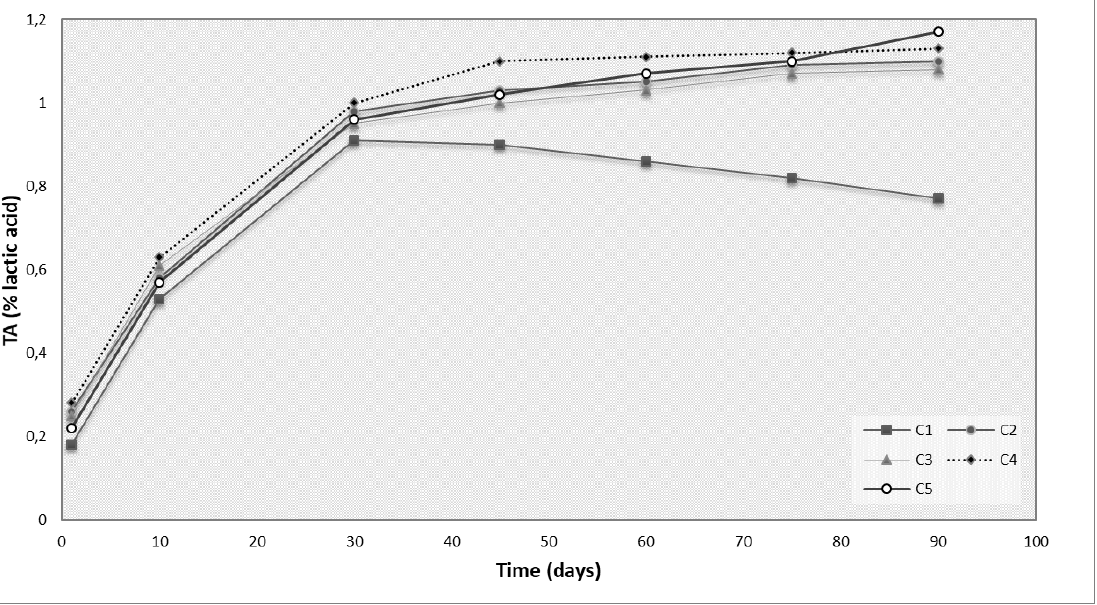
Figure 2. Titratable acidity (% lactic acid) changes in Feta-type cheese during ripening for 60 days